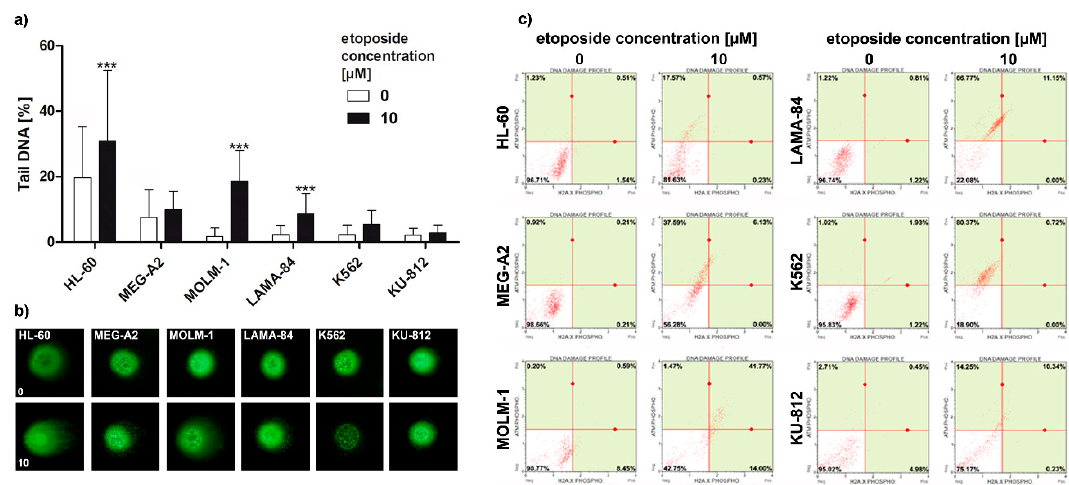
Figure 5. DNA damage response to double strand breaks (DSBs) in BCR/ABL1 -positive cell lines. ( a ) Neutral comet assay analysis of DSBs. As an DSBs inducer, 24 h treatment with 10 µ M etoposide was used. DNA damage marker, the % tail DNA was used. The bars indicate SD, n = 100, *** p < 0.001, compared to the control (ANOVA and Dunnett’s a posteriori test); ( b ) The typical images are shown. DNA was visualized using YOYO-1 staining. Images were taken using an Olympus BX61 fluorescent microscope with objective 20×; ( c ) phospho-ATM and phospho-H2AX were measured after 24 h treatment with etoposide using flow cytometry and Muse™ Multi-Color DNA Damage Kit.